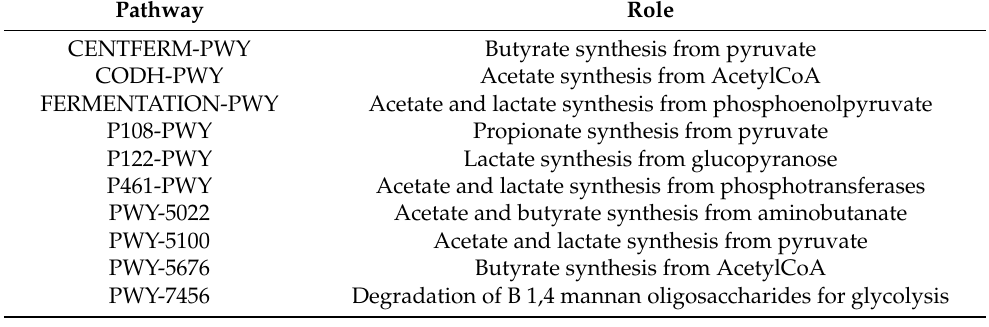
Figure 5. Relative frequency variation of the main fecal bacterial genera in control, YCW-15, and YCW-30 groups. a,b,c Boxes with the same letters are similar at p ≤ 0.00238i. * Genera with significant differences. A total of 487 metabolic pathways of the 16S gene were found in the present study. However, only ten pathways (3.23%) that were related to the fermentation products (Table 6) were used (3,094,291 sequences). Figure 6 summarizes the absolute results of the fermentation sequences in the pathways. Table 6. Fermentation pathways related to bacterial fermentation products using the MetaCyc database.